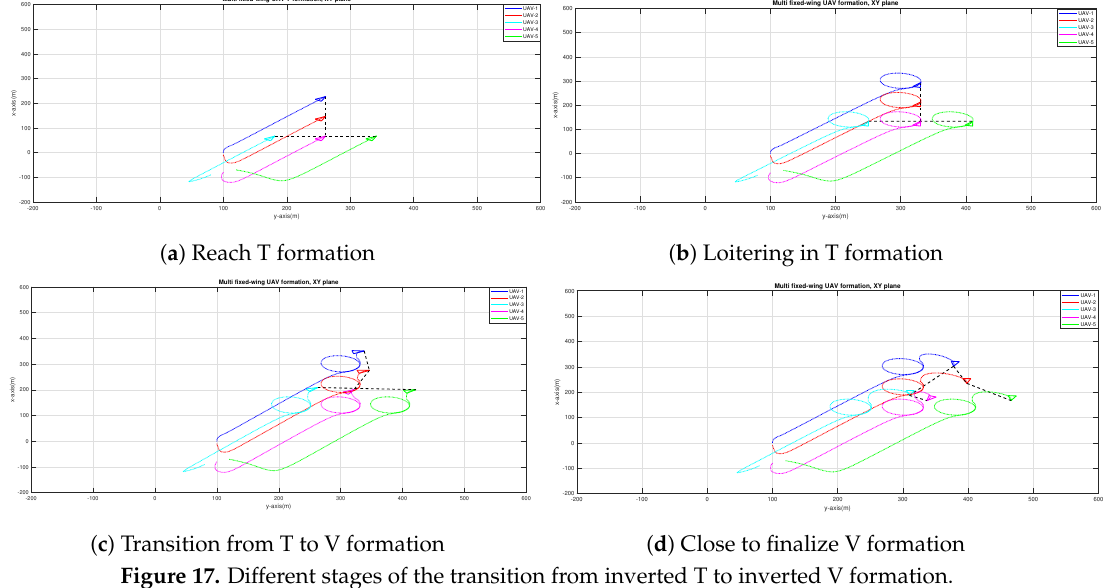
Figure 17. Different stages of the transition from inverted T to inverted V formation. Figure 18a,b complete the transition along three formations: After going from inverted T to inverted V formation, the UAVs go from inverted V to Y formation (Figure